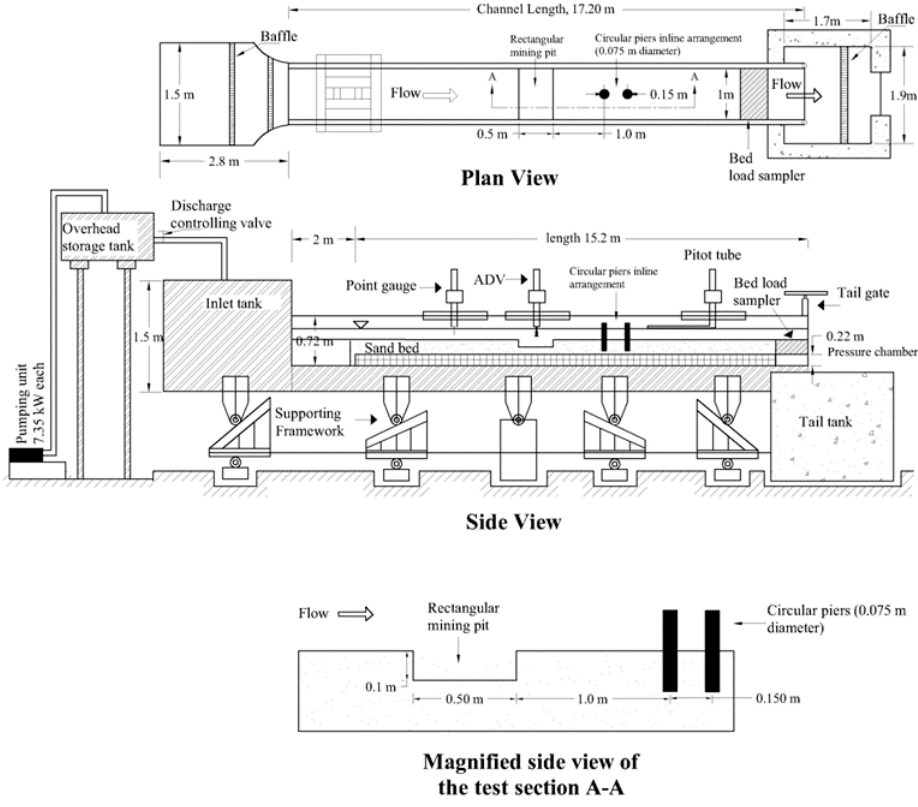
Figure 1. Representational drawings of the experimental setup.